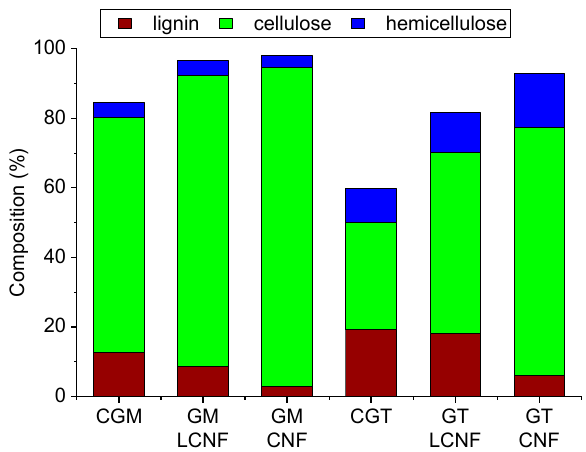
Figure 1. Composition (%) of cotton gin motes (CGM), cotton gin trash (CGT) and cellulose nanofibers (CNFs).